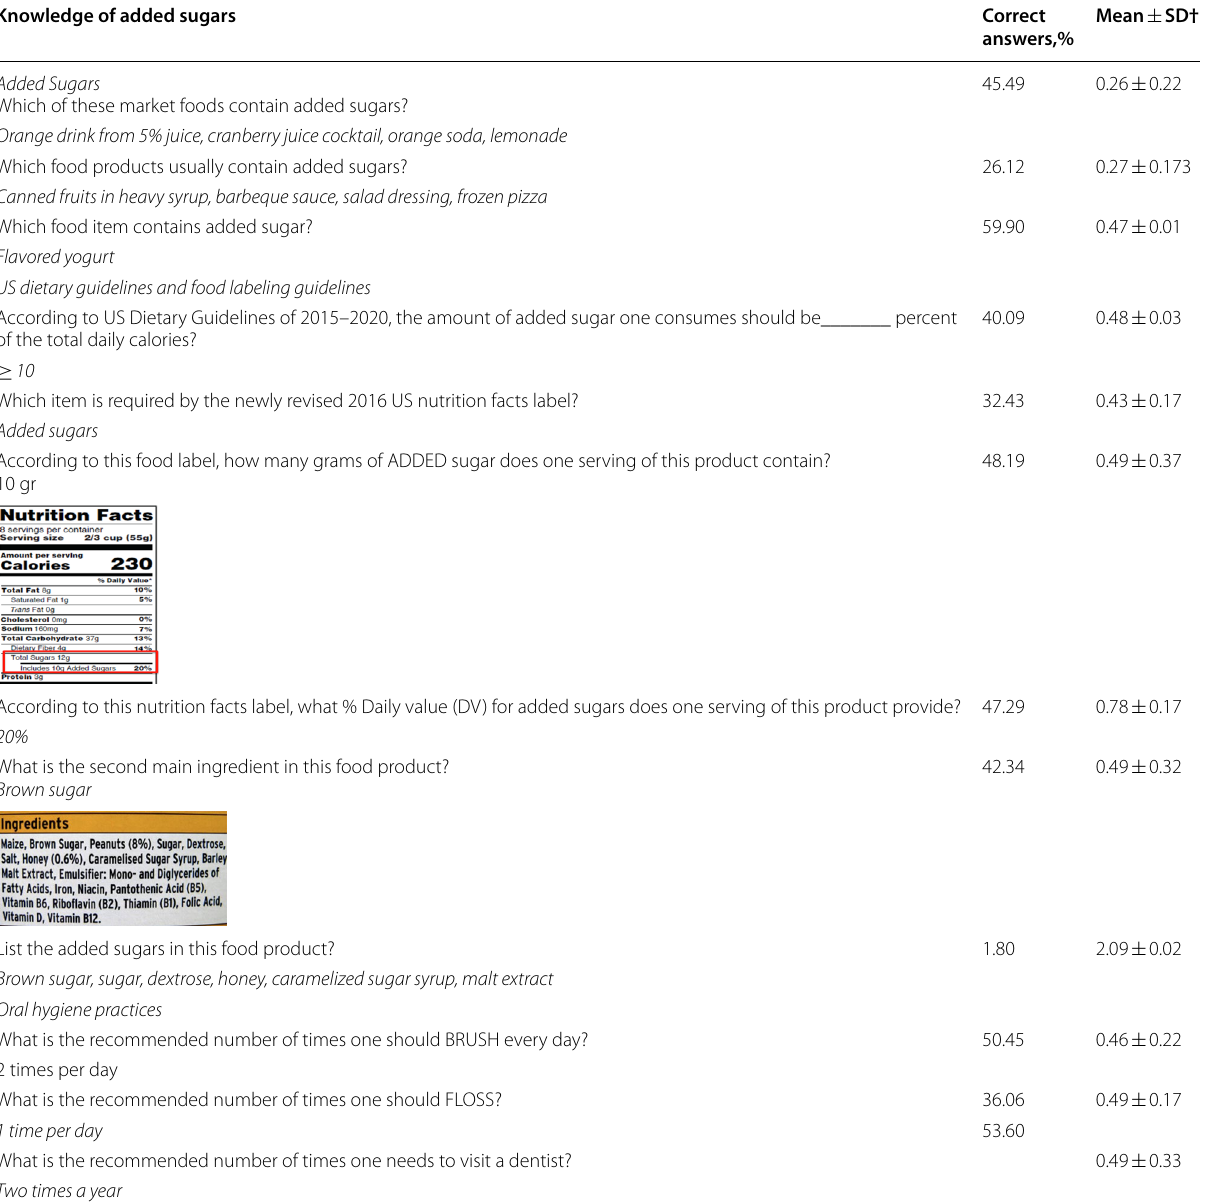
Table 2 Correct answers and mean scores of knowledge questions ( n 222)*